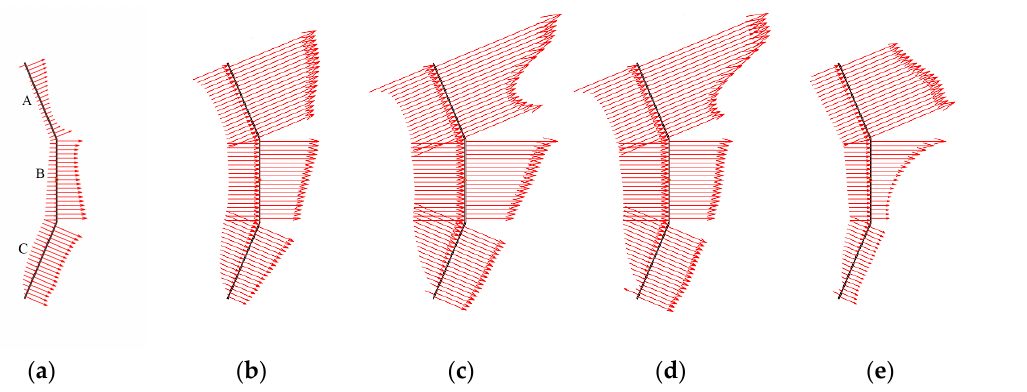
Figure 9. Variation of the aerodynamic pressure distribution on the surface of the bent plate in half cycle. ( a ) t/T = 0.0 . ( b ) t/T = 0.1 . ( c ) t/T = 0.2 . ( d ) t/T = 0.3 . ( e ) t/T = 0.4 . ( f ) t/T = 0.5 .